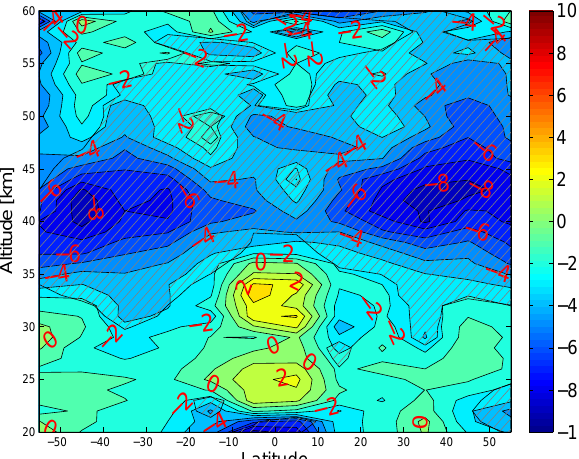
Fig. 14. The ozone trend in % per decade for different latitudes for 1984–1997. Shaded areas show regions where trends are statisti- cally different from zero at the 95%